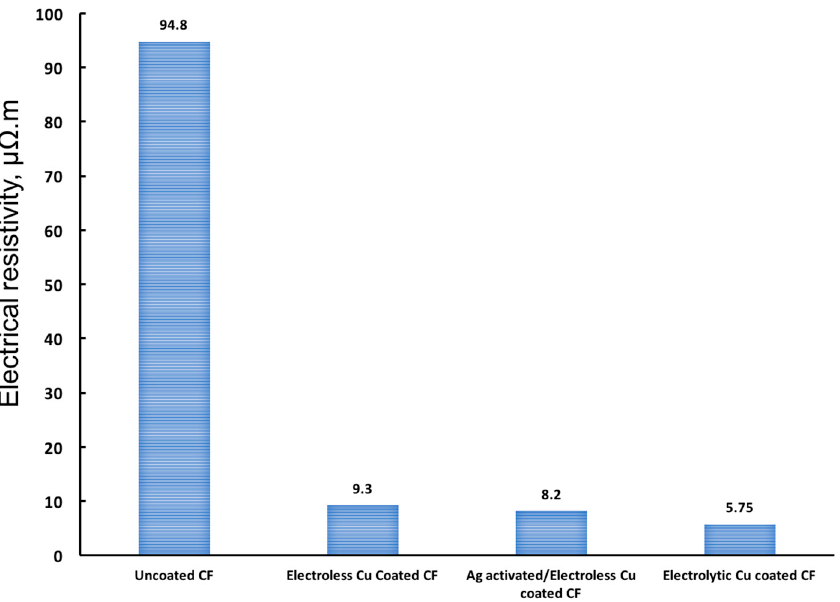
Figure 13. Electrical resistivity of the prepared carbon fiber/copper composites.